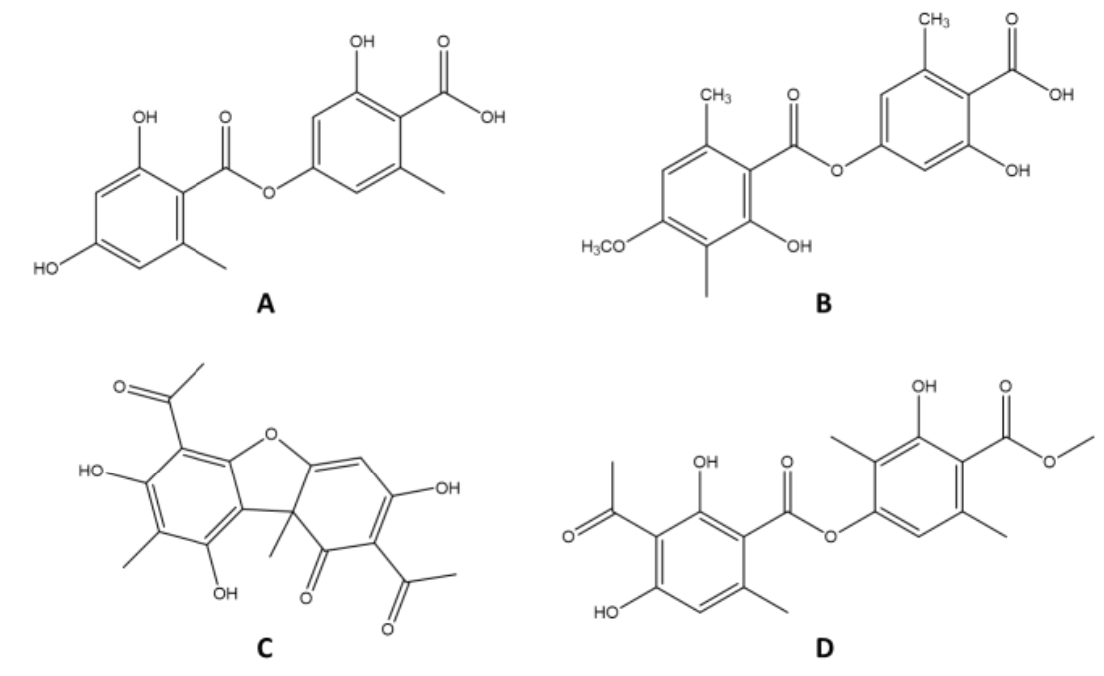
Figure 2. Chemical structures of compounds identified in the Xanthoparmelia stenophylla extracts: ( A ) lecanoric acid; ( B ) obtusic acid; ( C ) usnic acid; ( D ) atranorin. Table 2. Retention time, absorbance maxima, and content of the identified lichen substances. Table 3. Linearity, range, the limit of detection, and the limit of quantification of the used chromato- graphic method for compounds identified in lichen Xanthoparmelia stenophylla